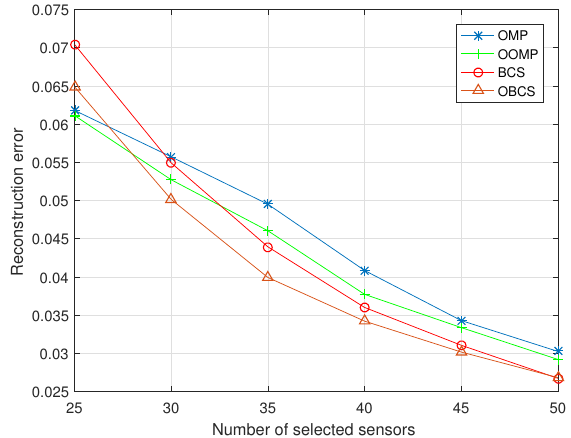
Figure 1. Reconstruction error versus different number of selected sensor